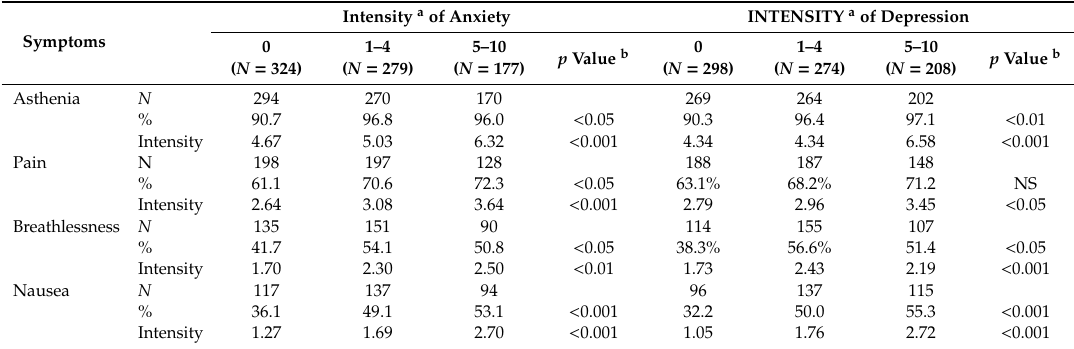
Table 5. Prevalence and intensity of four physical symptoms in 780 patients according to the intensity of anxiety or